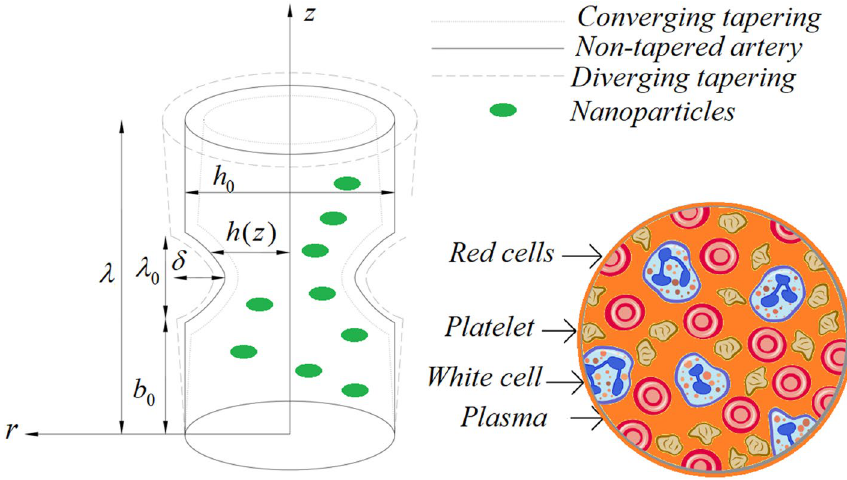
Figure 1. Simplified configuration of blood flow through the tapered artery and their composition in the presence of